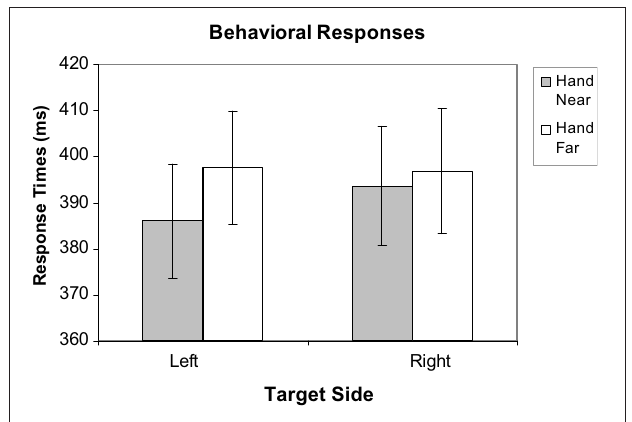
FIGURE 3 | Mean response time data for Hand Near and Hand Far conditions for targets appearing on left and right sides of the display. Error bars represent standard